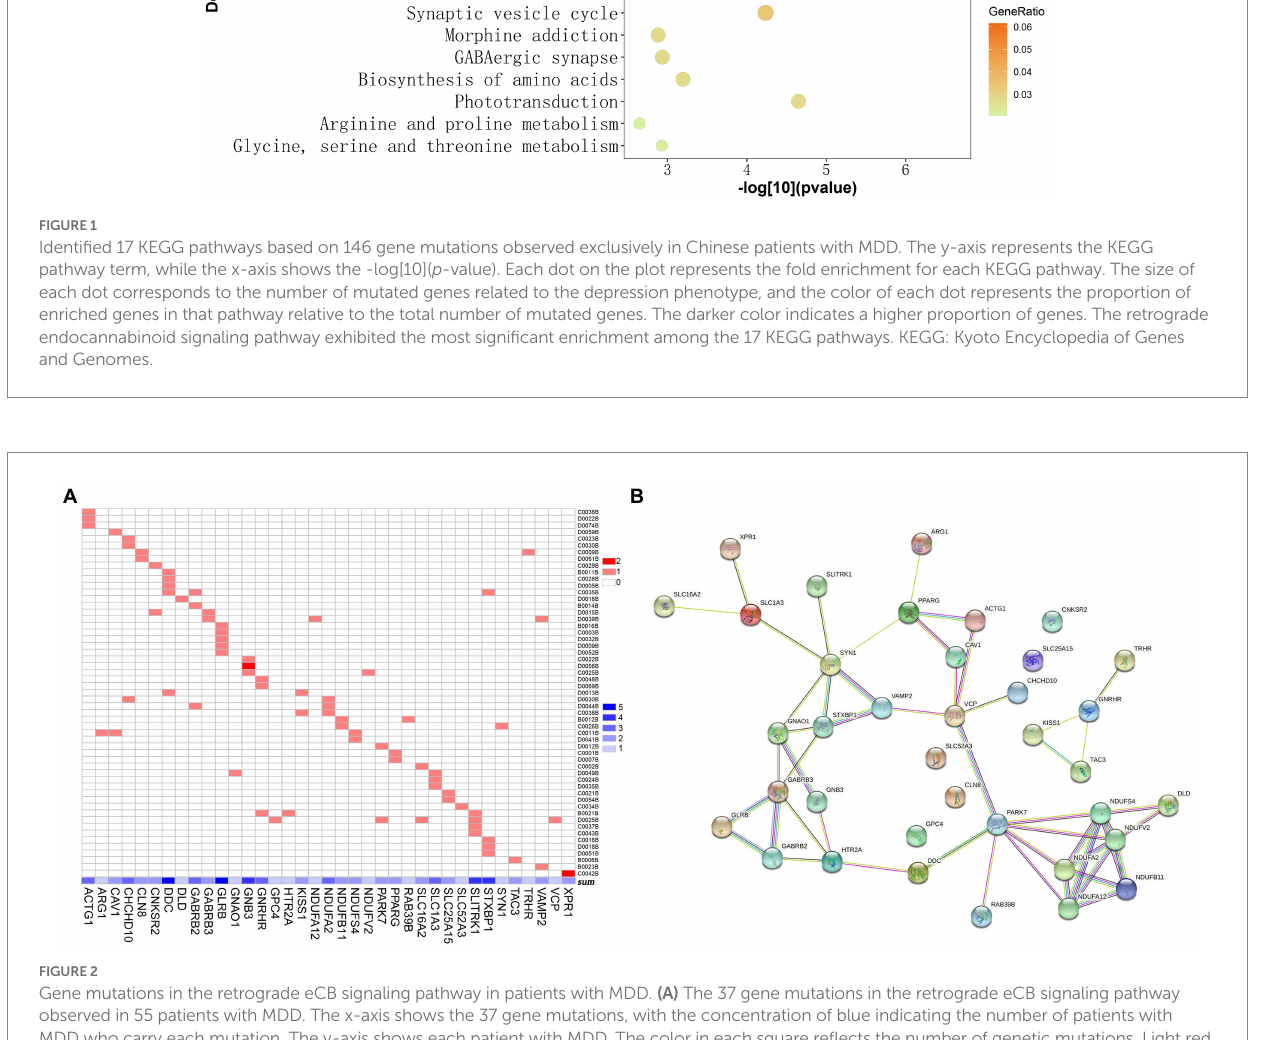
FIGURE 2 Gene mutations in the retrograde eCB signaling pathway in patients with MDD. (A) The 37 gene mutations in the retrograde eCB signaling pathway observed in 55 patients with MDD. The x-axis shows the 37 gene mutations, with the concentration of blue indicating the number of patients with MDD who carry each mutation. The y-axis shows each patient with MDD. The color in each square reflects the number of genetic mutations. Light red indicates that the gene is a heterozygous mutation, and dark red indicates a homozygous mutation. (B) The biological functions of the genes in the eCB signaling pathway based on the protein–protein interaction network analysis. Each node represents the proteins encoded by the genes, the contents of which are the 3D structures of proteins. Edges represent protein–protein associations contributing to a shared function. Different classifications are indicated by different colors. Known interactions are shown in blue and rose-red, based on information from curated databases and experimental studies, respectively. Predicted interactions are shown in green, red, and deep purple to indicate gene neighborhood, fusions, and co- occurrence, respectively. Yellow, black, and light purple represent interactions based on text mining, co-expression, and protein homology. eCB: